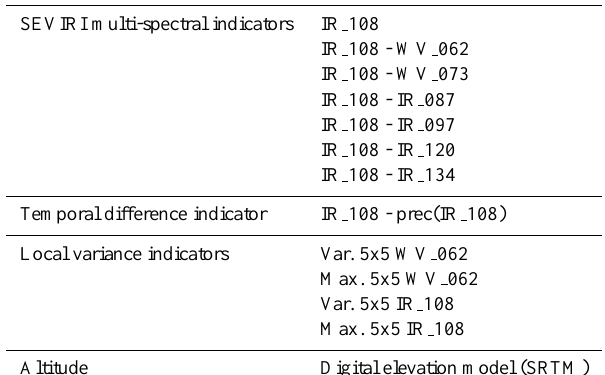
Table 1. Neural network input list. The SEVIRI channels are de- noted following the Eumetcast standard (i.e. IR 108 means infrared